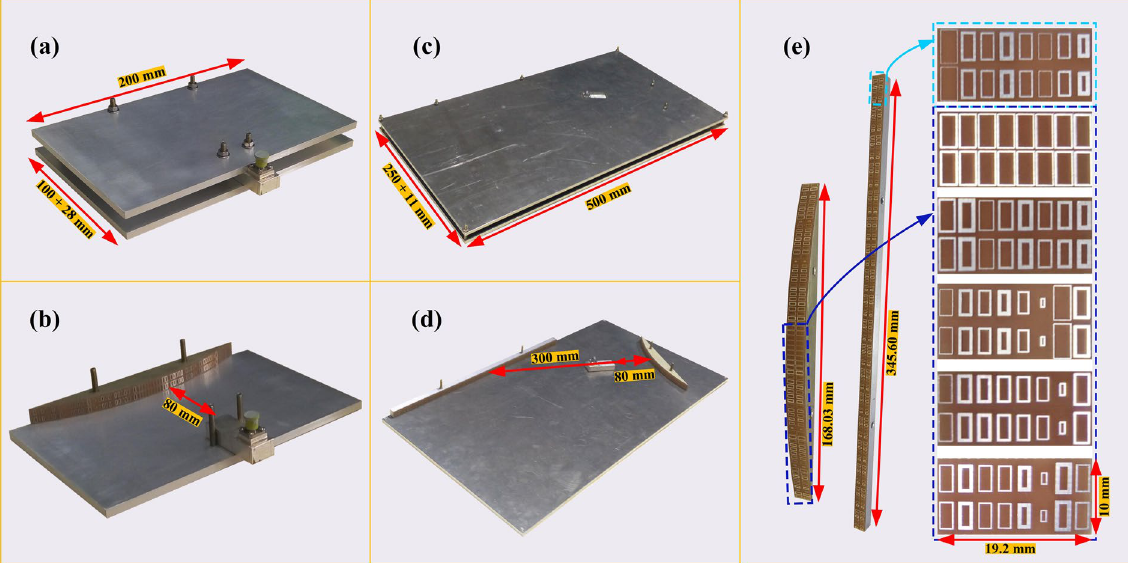
Figure 7. Manufactured photos of the optimized convex meta-mirror and the dual reflecting system. ( a ) The whole structure of the convex meta-mirror. The parallel plate waveguide has the size of (100 + 28) × 200 mm 2 , where the WR62 waveguide has additional 28 mm embedded length in the parallel plate waveguide in the experimental setup. ( b ) The whole convex meta-mirror without the upper plate. ( c ) The whole system of the dual reflecting system. The parallel plate waveguide has the size of (250 + 11) × 500 mm 2 , where the additional 11 mm is the total thickness of the supporting bracket and the planar meta-mirror. ( d ) The dual reflecting system without the upper plate. ( e ) Magnified pictures of the planar meta-mirror, the convex meta-mirror, and the ring patches.